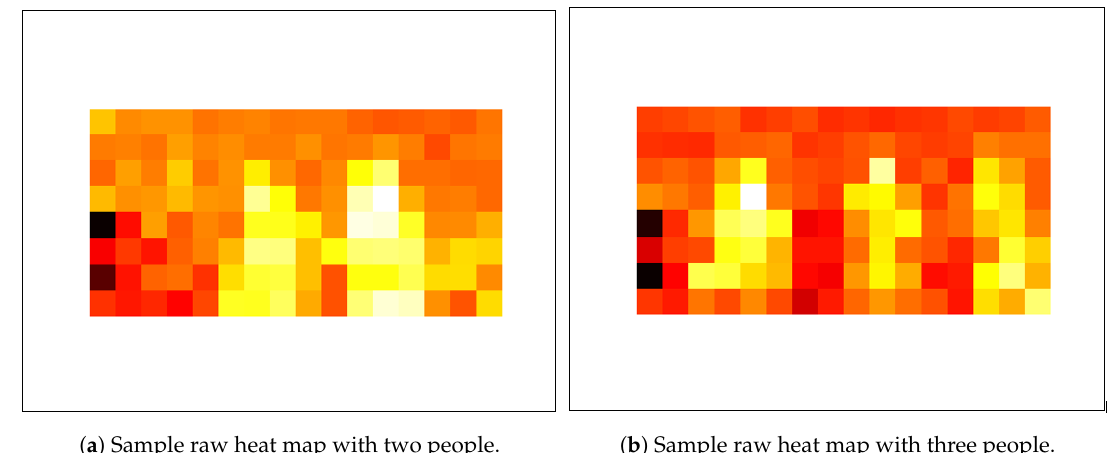
Figure 7. Sample heat maps before